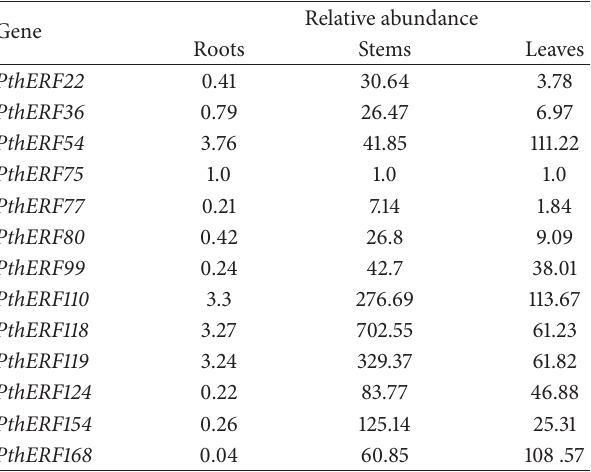
Table3:RelativemRNAabundanceofERFgenesindifferenttissues under normal